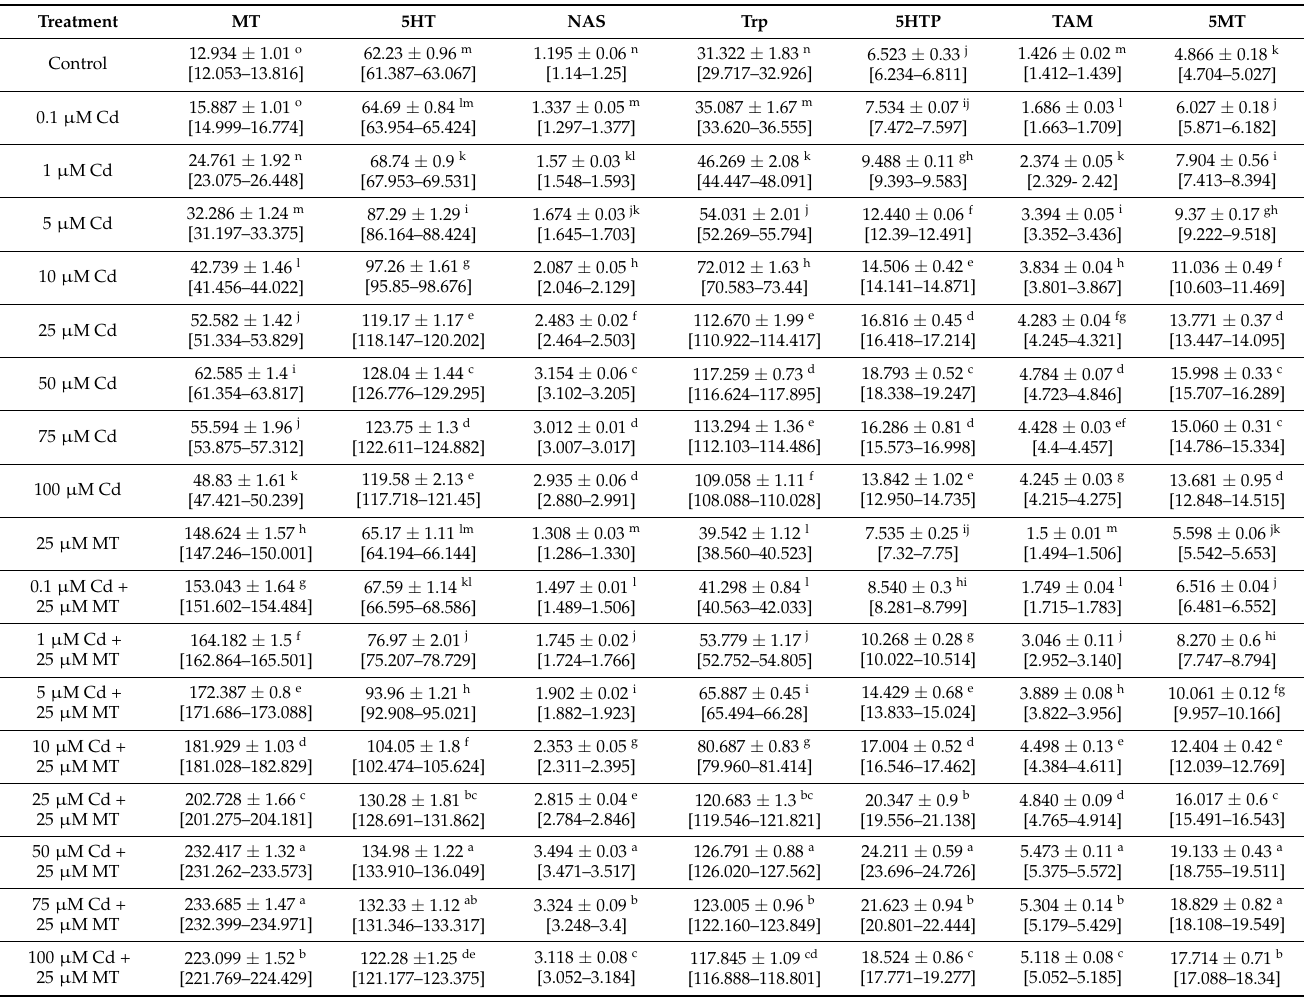
Table 2. The endogenous level of melatonin (MT) and its intermediates (ng/g fresh weight) in W. arrhiza exposed to cadmium (Cd) or/with MT after 7 days of cultivation. The results present the mean ( n = 5, biological replicate) ± standard deviation. The range in square brackets corresponds to the 95% confidence interval of the means. Means with the same letters are not significantly different ( p ≥ 0.05) according to Tukey’s post hoc